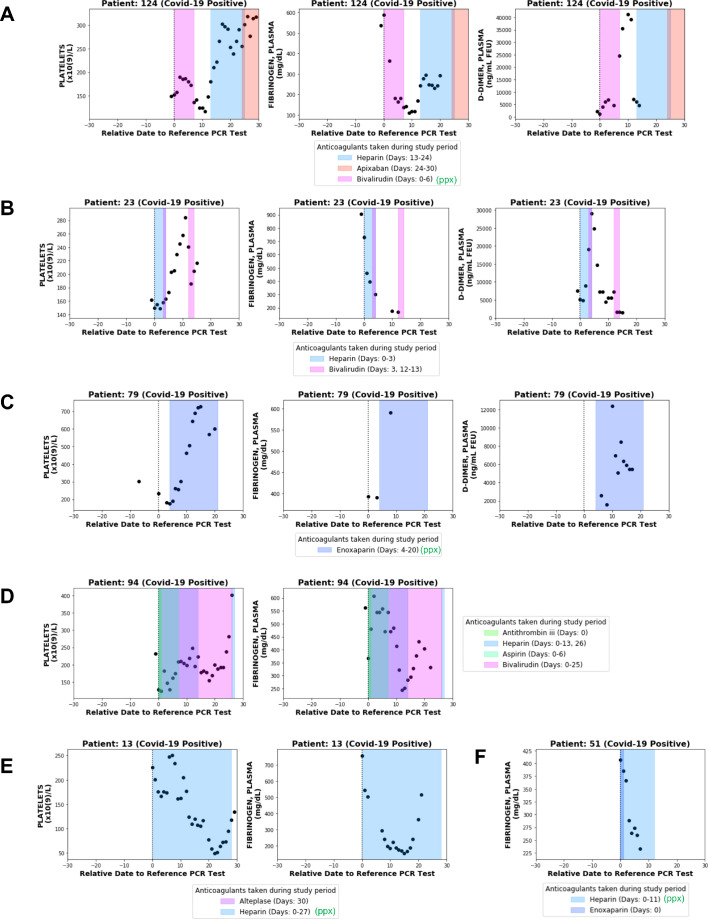
Longitudinal analyses of platelet counts, plasma fibrinogen, and D-dimer levels in individual patients with or without thrombotic disease.In each plot, shaded regions represent time periods when the patient was taking a specific anticoagulant or antiplatelet medication. Medications taken for prophylaxis are denoted in the legend with (ppx). (A) Patient 124 developed hemorrhagic and thrombotic phenotypes in the context of declining fibrinogen, declining platelets, and increasing D-dimers. This is consistent with a DIC-like coagulopathy. (B) Patient 23 developed clots in the setting of declining fibrinogen and elevated D-dimers but stable platelet counts which increased shortly thereafter. (C) Patient 79 developed clots while showing increases in platelet counts along with plasma fibrinogen and D-dimers. (D) Patient 94 developed clots with relatively stable platelet counts and steadily declining plasma fibrinogen. (E) Patient 13 did not develop clots or bleeding despite a coordinate decrease in platelet counts and fibrinogen which may be mistaken for a DIC-like coagulopathy. (F) Patient 51 did not develop clots despite showing a post-diagnosis decline in plasma fibrinogen similar to several patients in the thrombotic cohort.